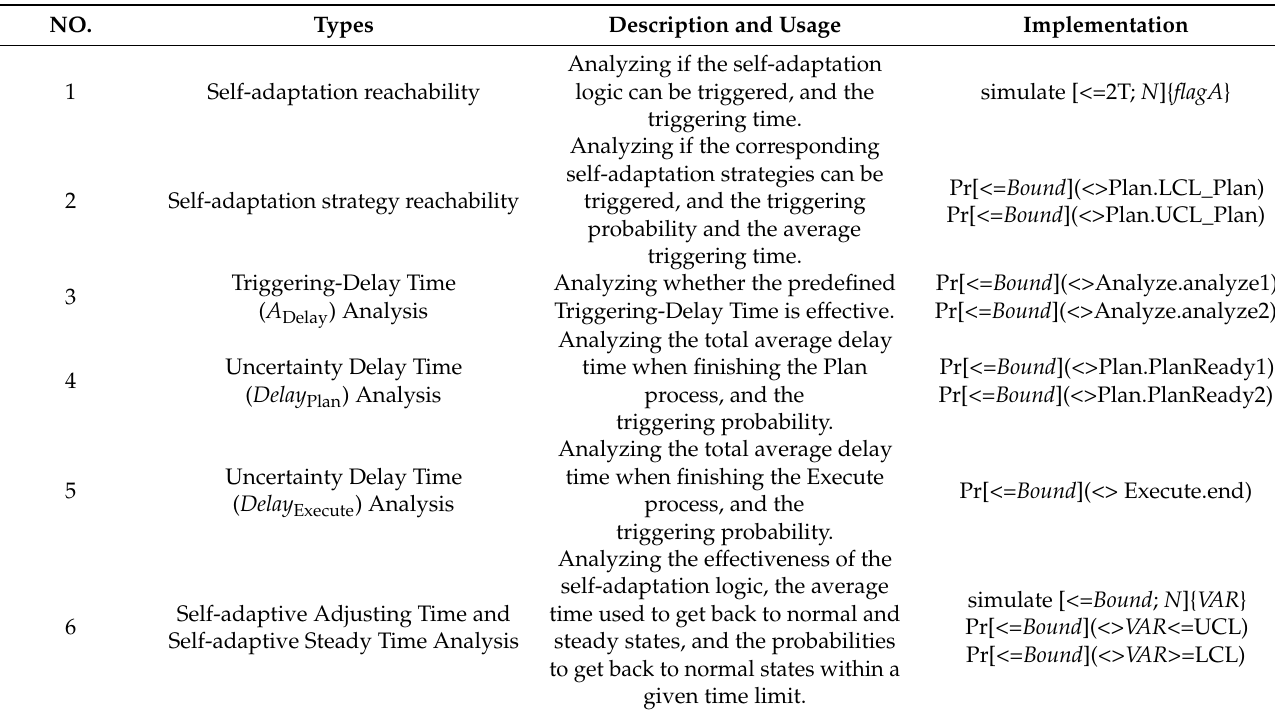
Table 1. Quantitative analysis templates for the SAS